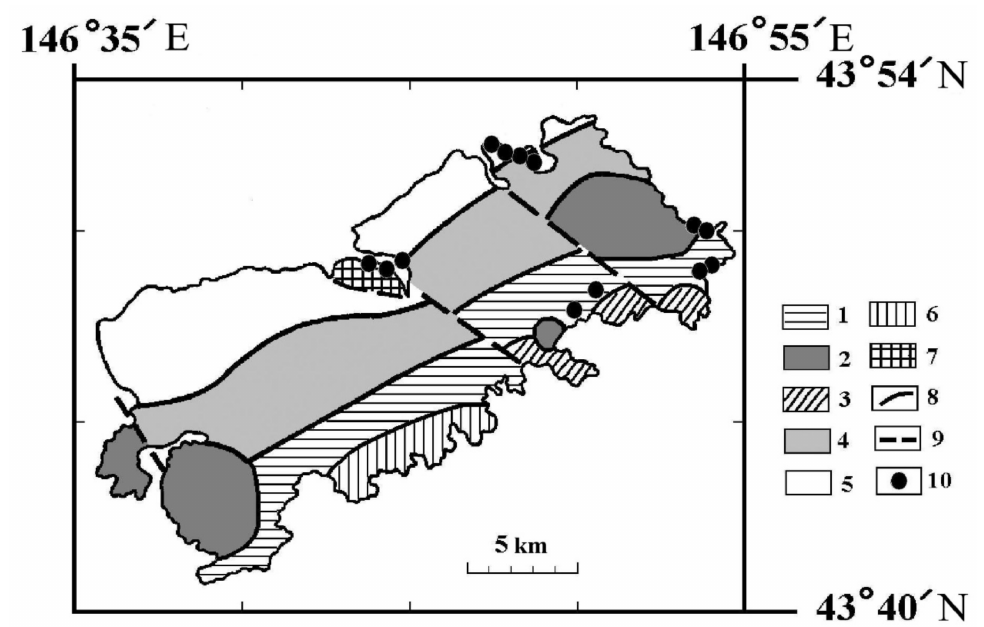
Figure 4. Geological chart of the Shikotan Island (Kuril Arc System) (according to [16,17]; with minor